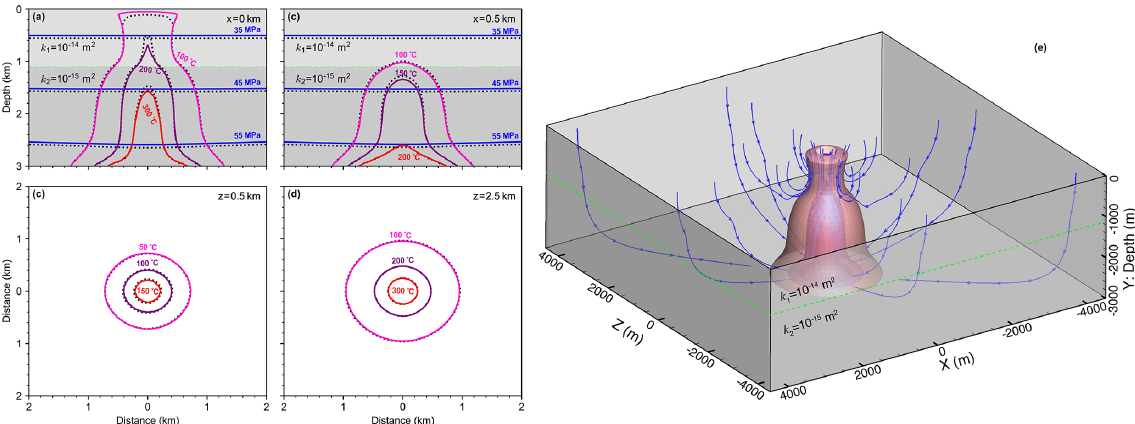
Figure 9. Results of three-dimensional model with two-layer permeability structure. Two layers are separated by the dashed green line. Contour lines for fluid pressure (blue) and temperature calculated from HydrothermalFoam are plotted as solid lines, and that from HY- DROTHERM are plotted as dotted black lines. Panels (a) and (b) show pressure and temperature contours on vertical slices, panels (c) and (d) show temperature contours on horizontal slices. Panel (e) shows three-dimensional isothermal surfaces and stream